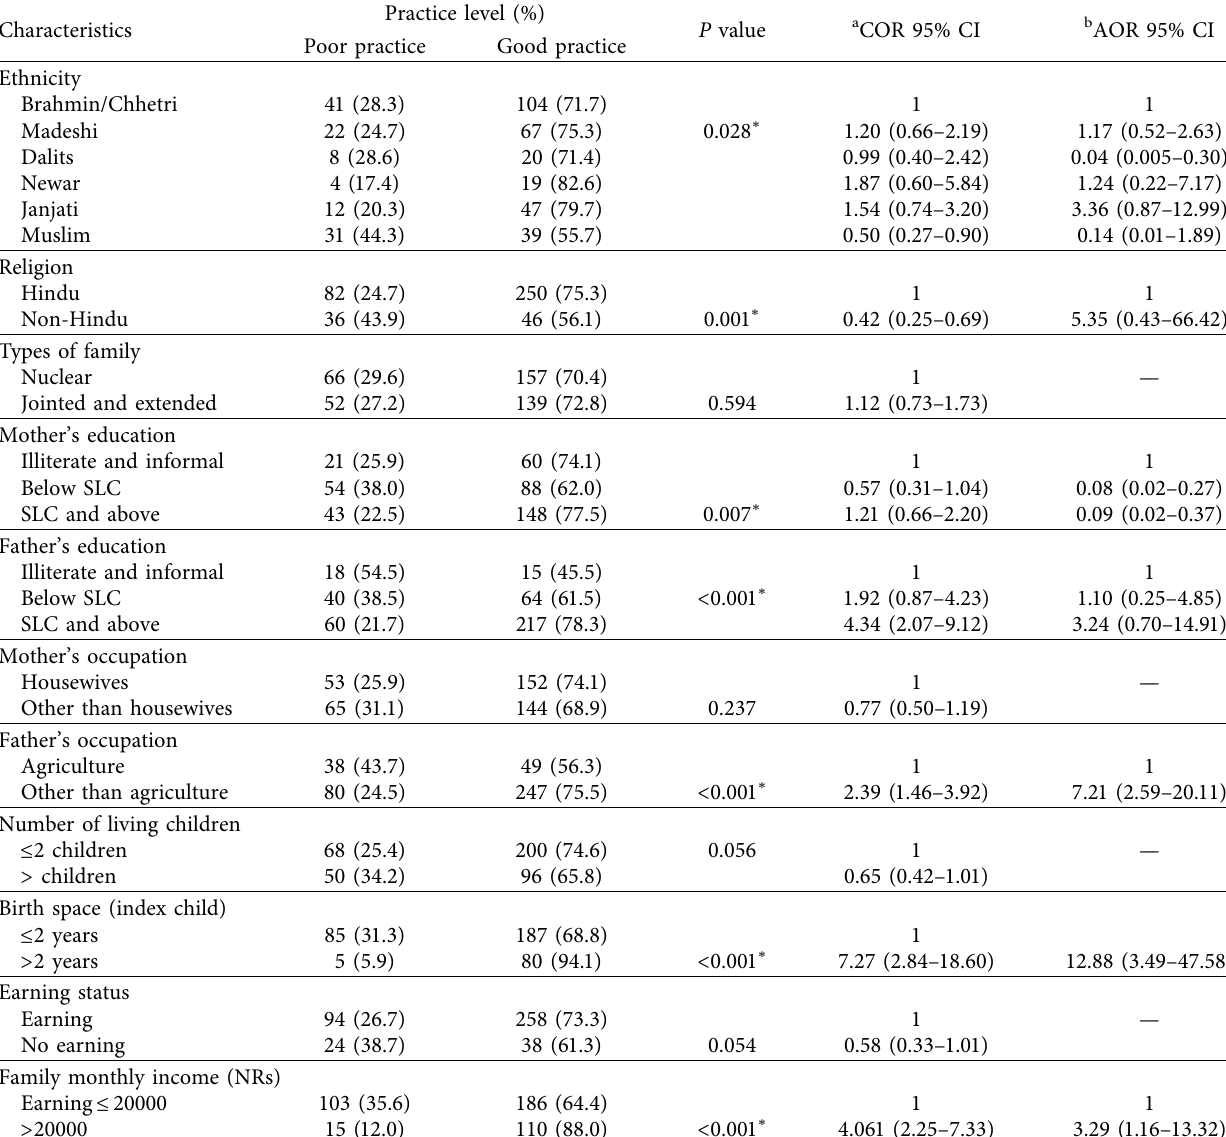
Table 4: Determinants of mother’s practice level of health promotion measures of infant with age group 6–12 months in a tertiary hospital of